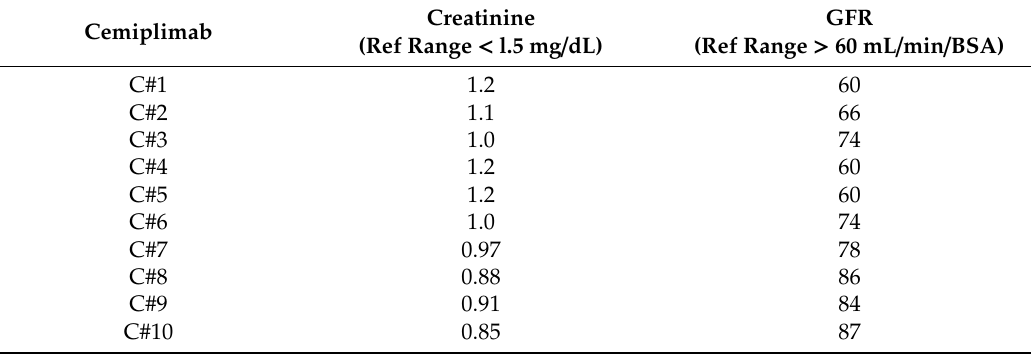
Table 1. Changes in creatinine and glomerular filtration rate (GFR) during treatment with cemiplimab (before each